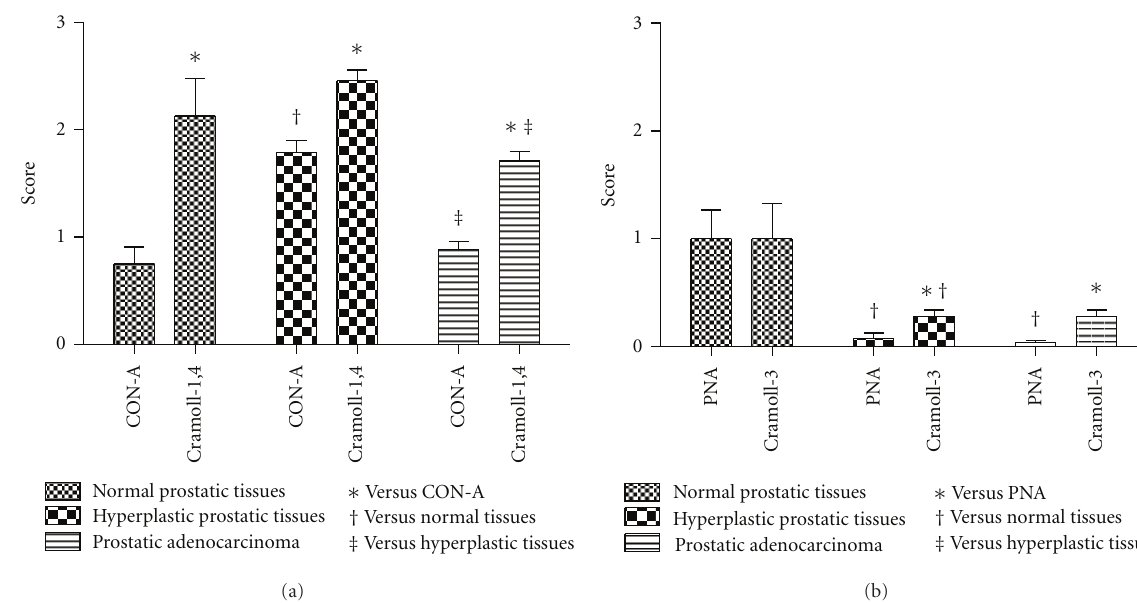
Figure 3: Statistical analysis of lectin histochemistry of normal human prostate, BPH, and PCa with Con-A and Cramoll 1,4 (a) and PNA and Cramoll 3 (b) ( P < .